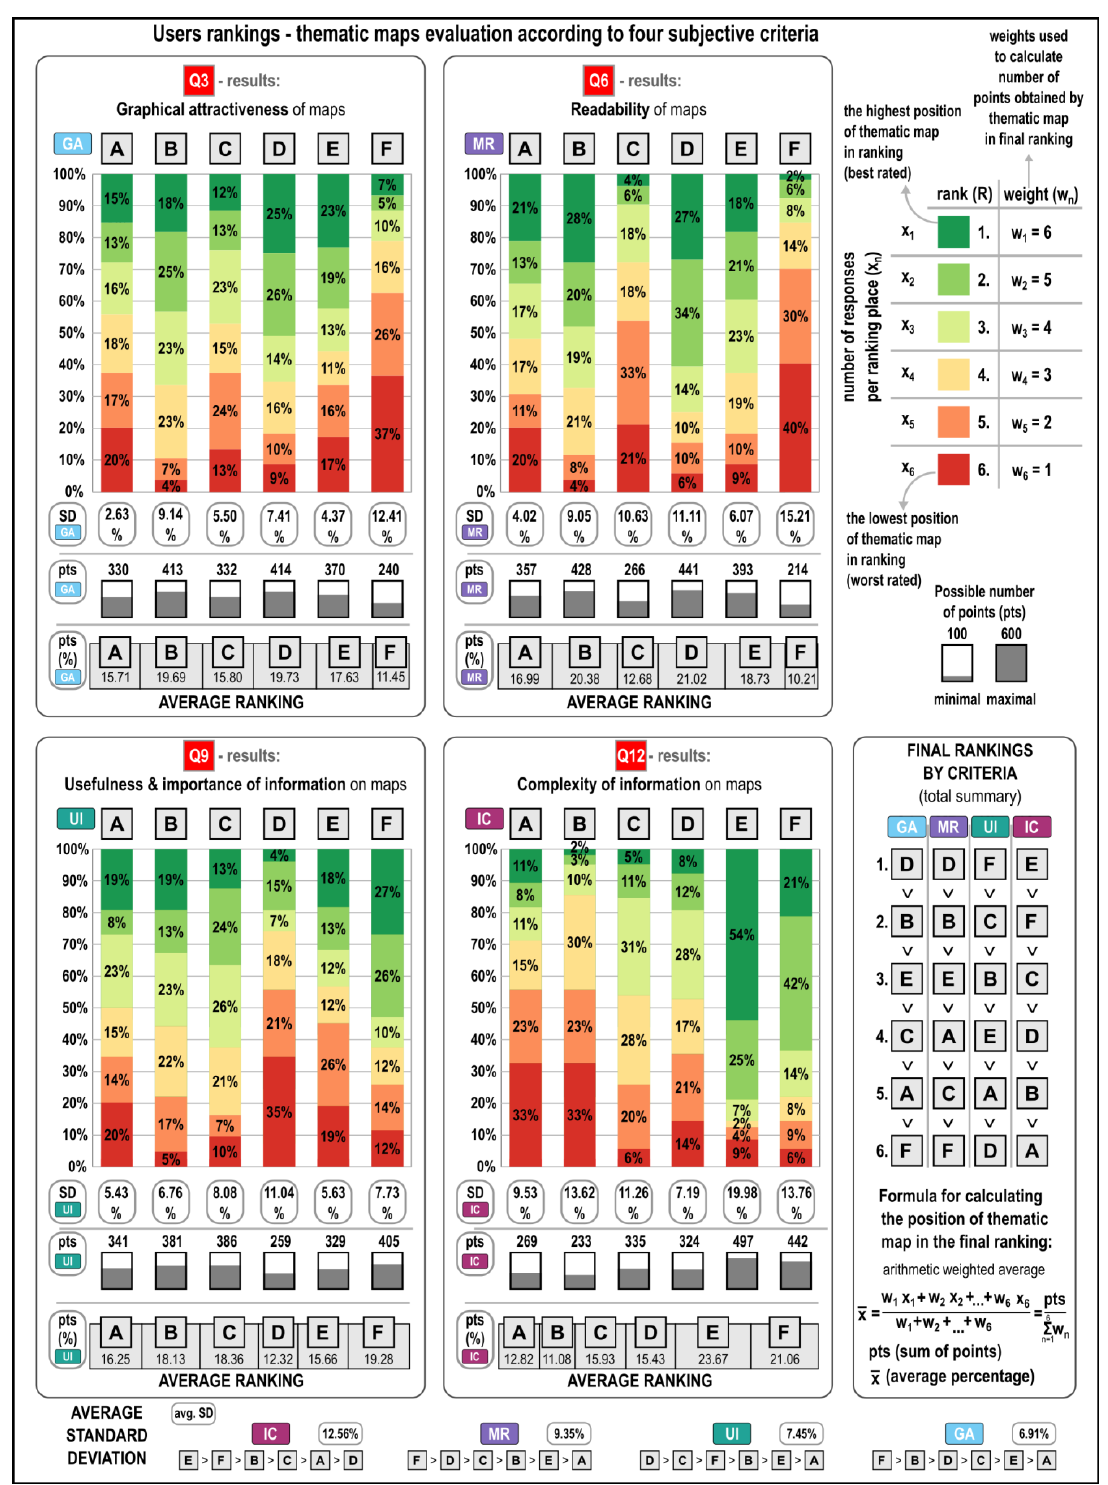
The percentages are arranged according to the ranking. At the top of each bar diagram the highest rank (rank 1—dark green) was placed, and at the bottom the lowest rank (rank 6—red) was placed.